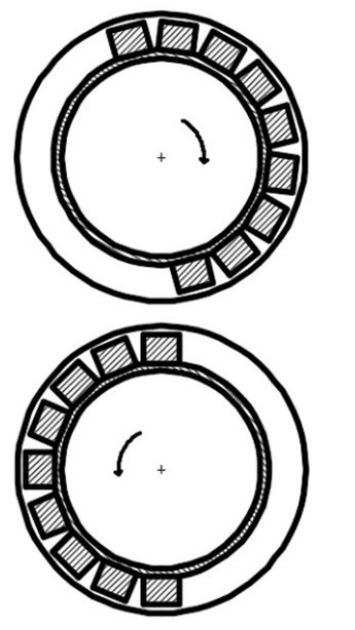
Figure 3. Cascade separator layout.